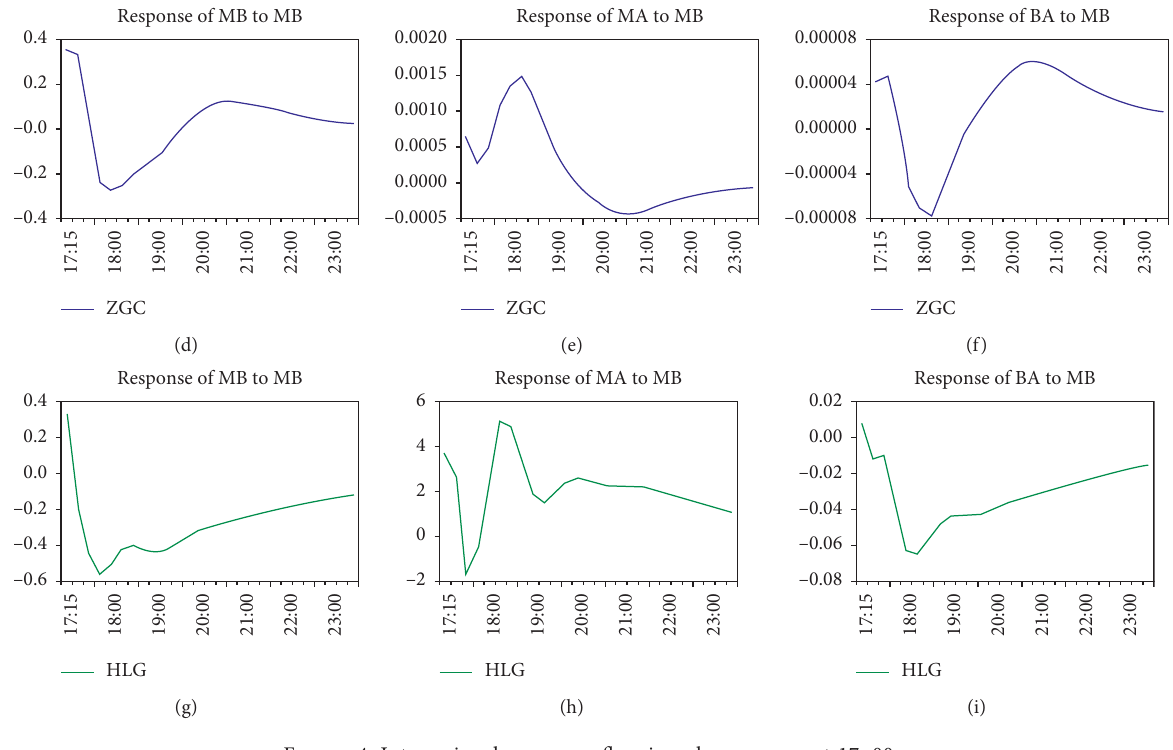
Figure 4: Intraregional passenger flow impulse response at 17: 00.